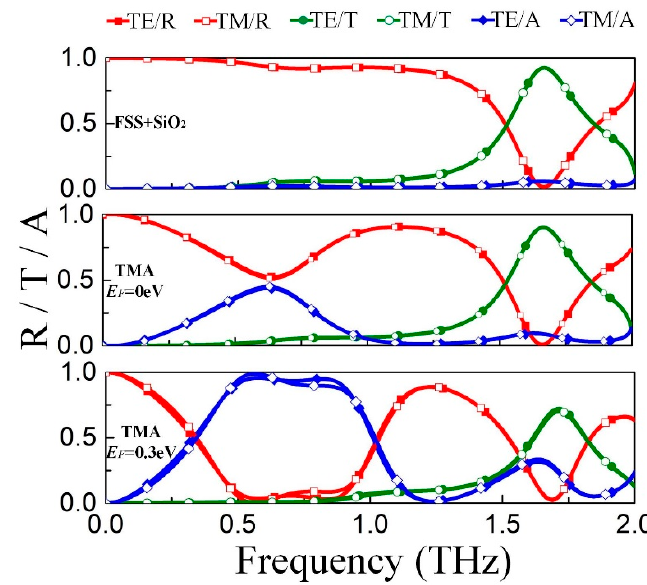
Figure 5. Reflection, transmission and absorption through the frequency selective surface (FSS) and the TMA backed with FSS. Top : FSS integrated with substrate; middle : TMA, E F = 0 eV; bottom : TMA, E F = 0.3 eV.